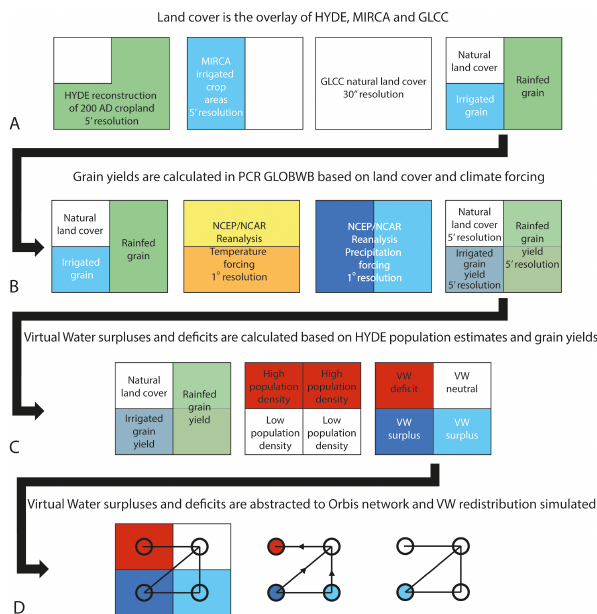
Figure 1. Schematic of our virtual water network of the Roman world. (a) The overlay of the History Database of the Global Envi- ronment (HYDE) cropland reconstructions for AD200, monthly ir- rigated and rainfed crop areas (MIRCA) and global land cover char- acterization (GLCC) forms the land cover attributes in our model. Regions are only assigned as irrigated where MIRCA irrigated re- gions overlap with historical cropland regions. (b) Grain yields in irrigated and rainfed agricultural regions are simulated in PC Raster Global Water Balance model (PCR-GLOBWB) based on 52 years of spatially and temporally variable temperature and precipitation forcing. (c) Regions are defined based on a Thiessen polygon op- eration between network nodes (Fig. S1). Virtual water surpluses and deficits are calculated for each region based on HYDE recon- structions of Roman population distribution and grain yields calcu- lated in PCR-GLOBWB. We fix the annual grain consumption at 200kg per person. (d) The virtual water surpluses and deficits are abstracted to the Orbis network and virtual water redistribution is simulated. Deficit nodes import virtual water from surplus nodes along the minimum cost path. Imports continue until the demand of deficit nodes is met. See Fig. S2 for a spatially explicit schematic of our virtual water network of the Roman